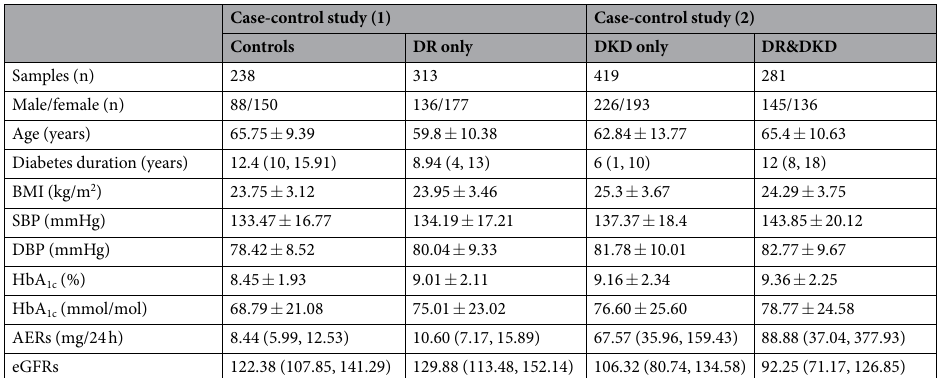
Table 3. Clinical characteristics of the participants in stage 1. Data are n, mean ± SD, or median (interquartile range). AERs = albumin excretion rates; BMI = body mass index; DBP = diastolic blood pressure; DKD = diabetic kidney disease; DR = diabetic retinopathy; eGFR = estimated glomerular filtration rate; HbA 1c = haemoglobin A 1c ; SBP = systolic blood